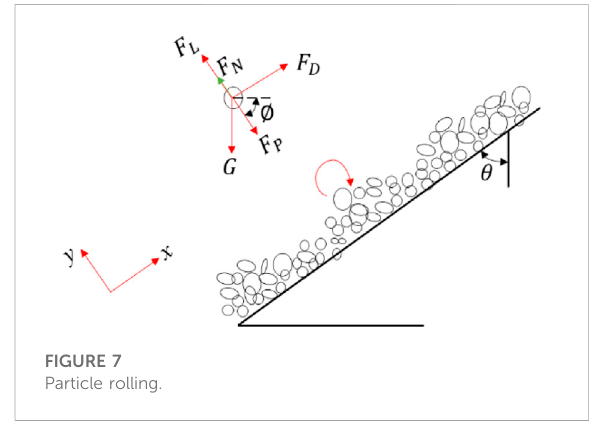
FIGURE 8 Cuttings diffusion in a control